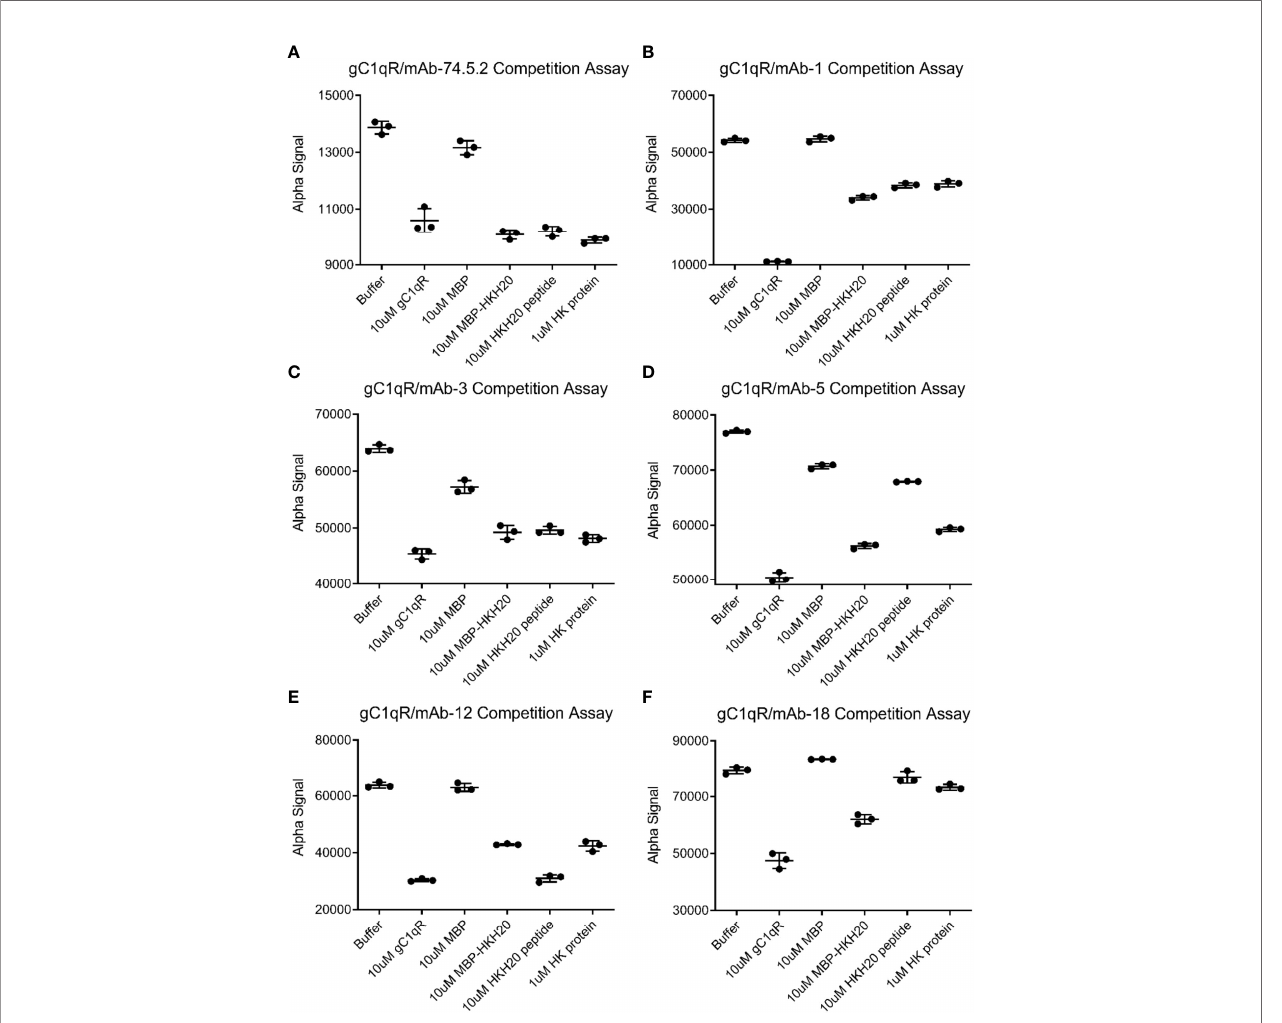
FIGURE 4 | Competitive Behavior of Novel Monoclonal Antibodies on the Interaction of gC1qR with High-Molecular Weight Kininogen (HMWK) Derived Ligands. Various anti-gC1qR monoclonal antibodies were incubated with chemically biotinylated gC1qR and used to generate a luminescent signal using a bead-based AlphaAssay approach. The abilities of a single concentration of HMWK-derived ligands, or various controls, to compete the luminescent signal were measured in triplicate. (A) Data for competition of binding between biotinylated gC1qR and mAb-74.5.2, which is known to block binding of HMWK to gC1qR (1, 24). Data shown in this panel were modi fi ed from Ghebrehiwet et al. (1). (B) Data for competition of binding between biotinylated gC1qR and mAb-1. (C) Data for competition of binding between biotinylated gC1qR and mAb-3. (D) Data for competition of binding between biotinylated gC1qR and mAb-5. (E) Data for competition of binding between biotinylated gC1qR and mAb-12. (F) Data for competition of binding between biotinylated gC1qR and mAb-18. Note that the wider black line represents the mean of the three measurements, while the thinner lines are values plus and minus one standard